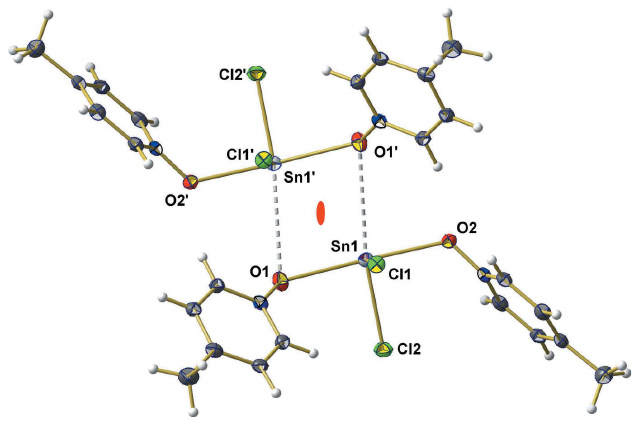
Figure 4 Ball-and-stick model of the dimeric aggregates found in the crystal structure of 2 looking down the crystallographic twofold rotation axis marked in red; additional Sn—O distances are indicated by dashed sticks in gray [symmetry codes used to generate equivalent atoms marked 0 : (cid:5) y , 1 (cid:5) y , (cid:5) 1 (cid:5) z 1 (cid:5) x , y , 3 + z ; (’’) x , 3 + z . 2 2 2 2 2